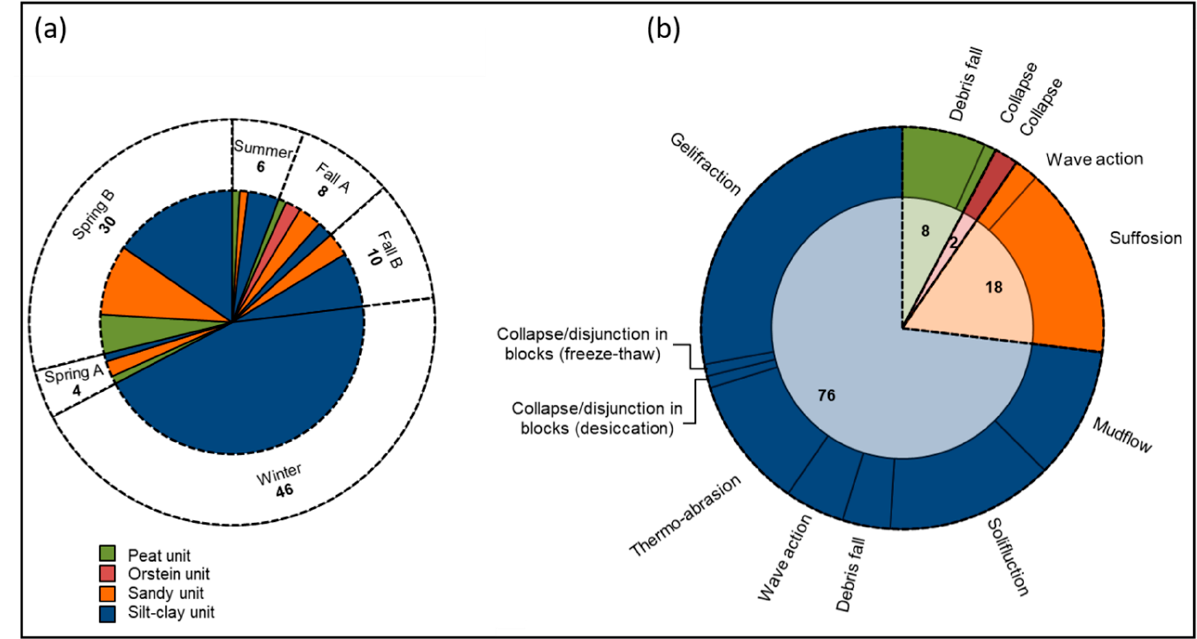
Figure 8. Number of events per lithological unit per season ( a ), and processes affecting the different lithologies in Zone B ( b ).